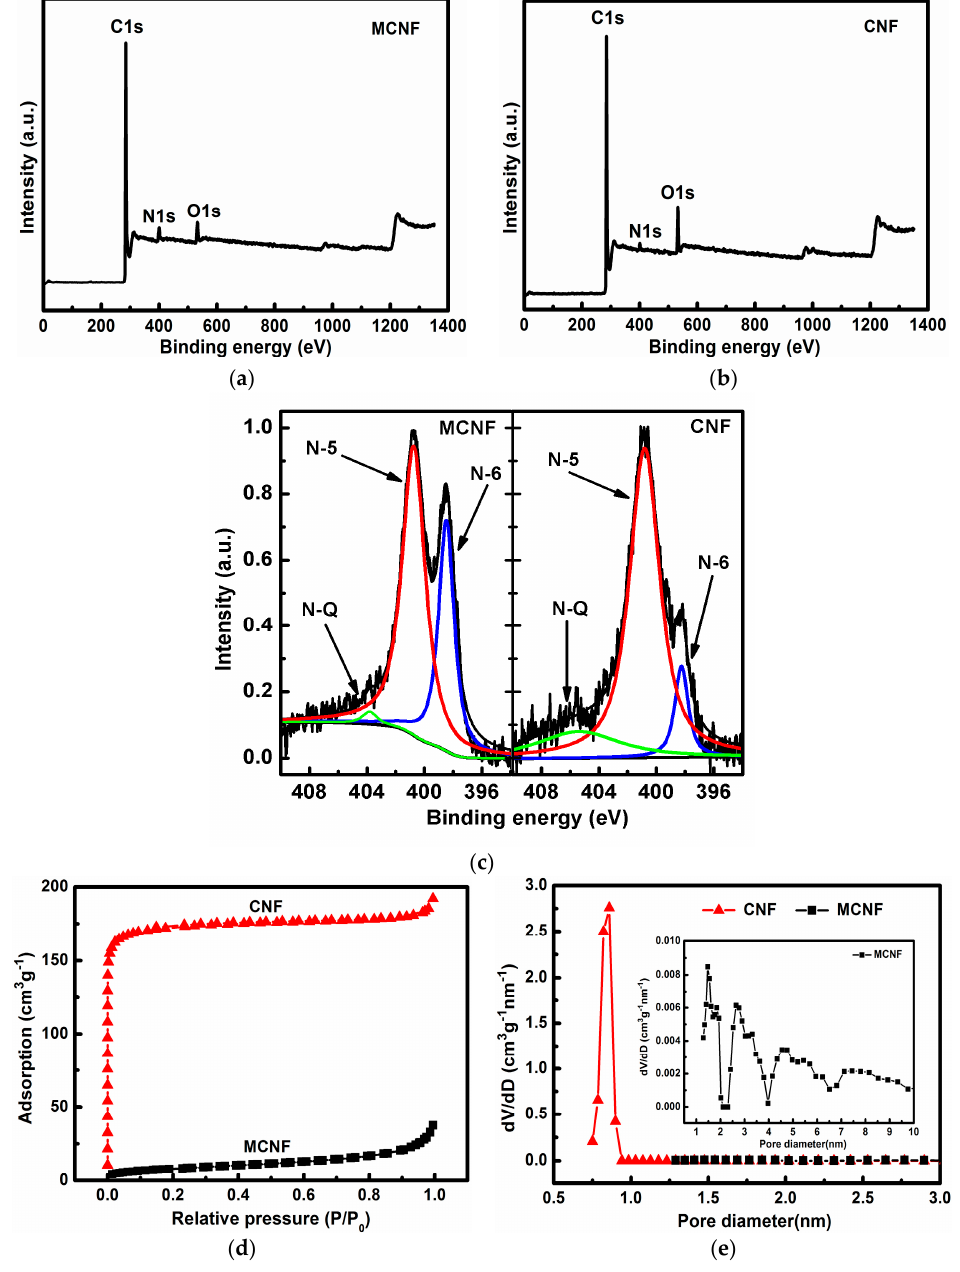
Figure 3. X-ray photoelectron spectroscopy spectra of ( a ) MCNF; ( b ) CNF; ( c ) N1s of CNF and